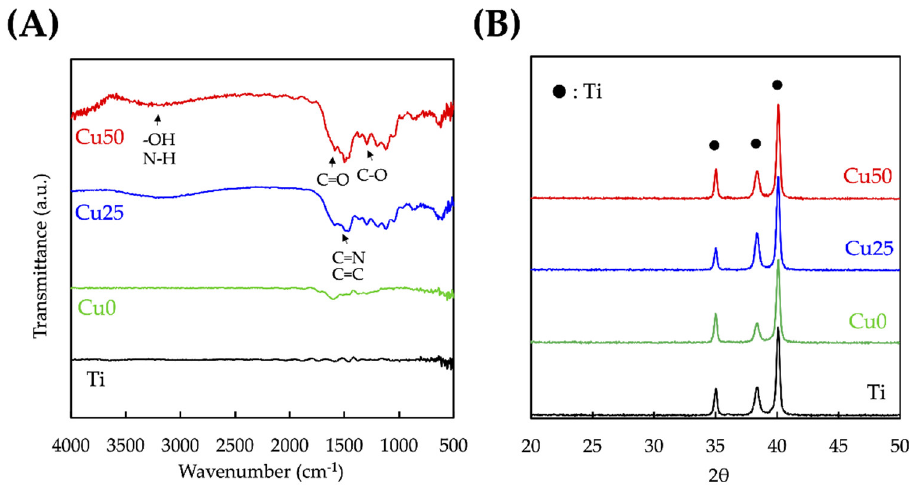
Figure 4. ( A ) FTIR and ( B ) XRD profiles of the 3D-printed Ti6Al4V scaffolds before and after PDA/Cu coating.